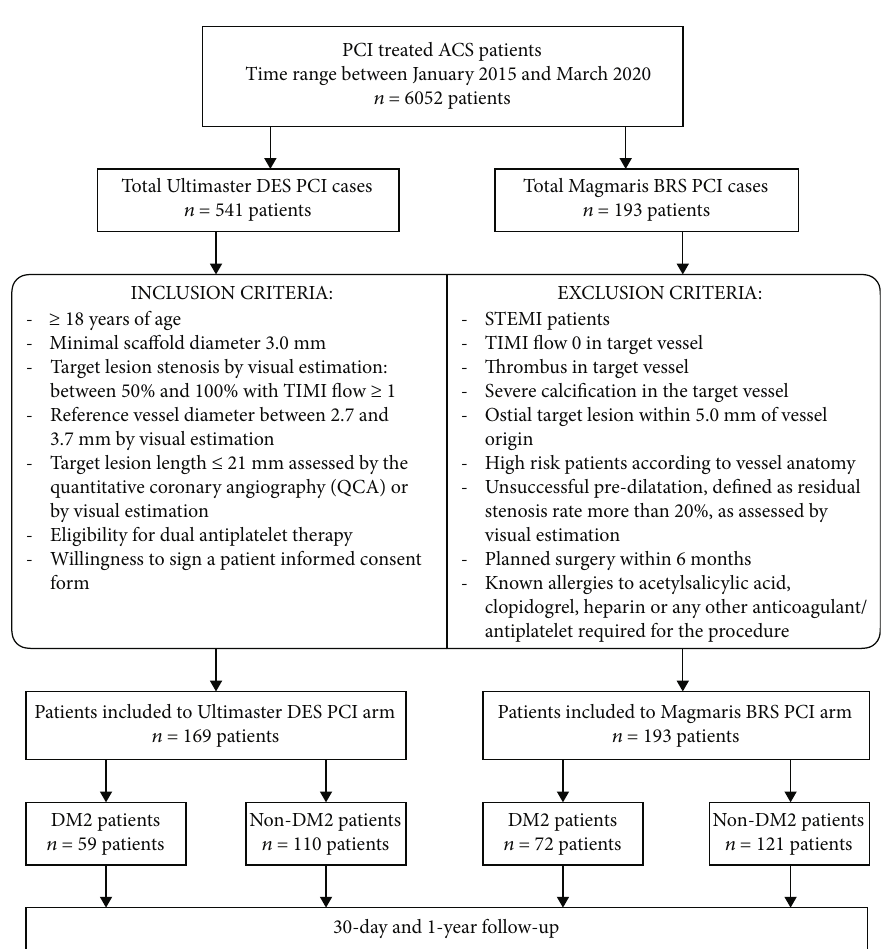
Figure 1: Study inclusion and exclusion